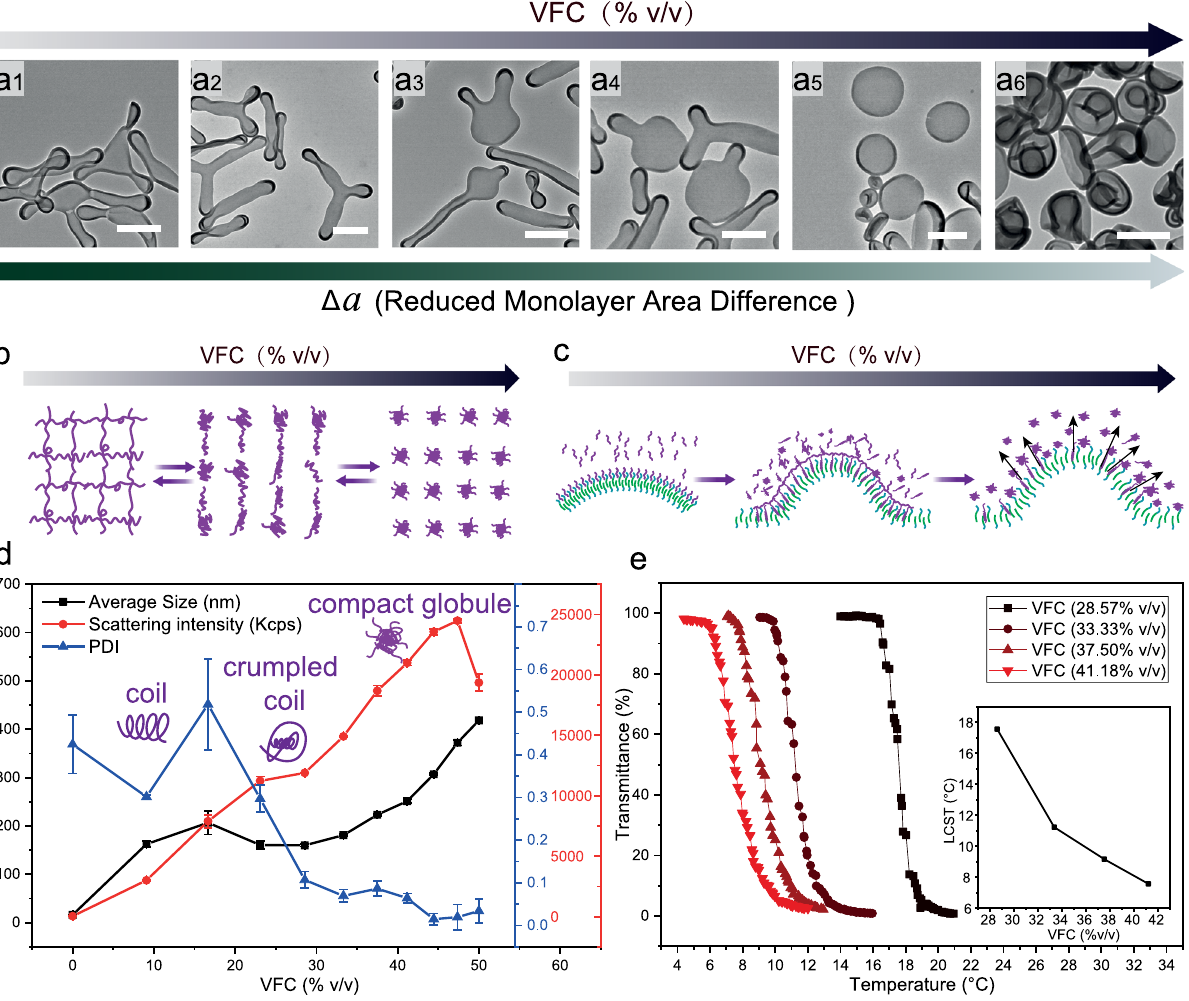
Fig. 6 Reversible PNIPAm-membrane Interaction. TEM image of polymersomes depicting changes in the membrane curvature during the increase of VFC ratio from 23.07% to 37.5% (black arrow). The reduced monolayer area difference decreases by increasing VFC ratio (green arrow) ( a 1 – a 6). Schematic representation of PNIPAm aggregation ( b ) and PNIPAm membrane interaction ( c ) with the increase of VFC ratio. Dynamic light scattering measurements for the observation of the aggregation of PNIPAm with the change of VFC, the structure of PNIPAm changed from coil, crumpled coil to compact globule. Values are mean ± SD ( d ). PNIPAm transmittance measurement by UV – vis spectroscopy to detect the shift of LCST with the change of VFC ( e ). Scale bar 500 (Fig. 6a6). With the increase of the VFC, the shape changing ends up with stomatocytes, which is similar to the shape transformation